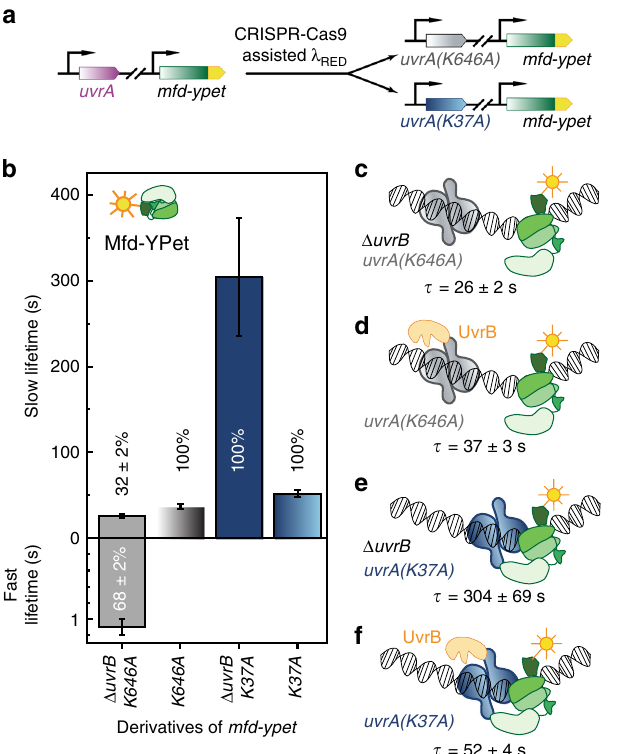
Fig. 3 Measurements of Mfd-YPet binding lifetimes in cells expressing mutant UvrA de fi cient in ATP binding and hydrolysis. a The wild-type uvrA allele was replaced by the mutant allele in mfd-YPet cells, so that mutant cells either express the distal ATPase mutant UvrA(K646A) or the proximal ATPase mutant UvrA(K37A) from the chromosome. b Bar plots show lifetimes of DNA-bound Mfd-YPet in the corresponding genetic backgrounds. Where two kinetic sub-populations are detected, the fast lifetime is displayed in the lower panel. Numbers in percentages represent the amplitudes of kinetic sub-populations (see Supplementary Figs. 2, 3). c Lifetime of Mfd-YPet in mfd-YPet uvrA(K646A) Δ uvrB (26 ± 2 s; N repeats =